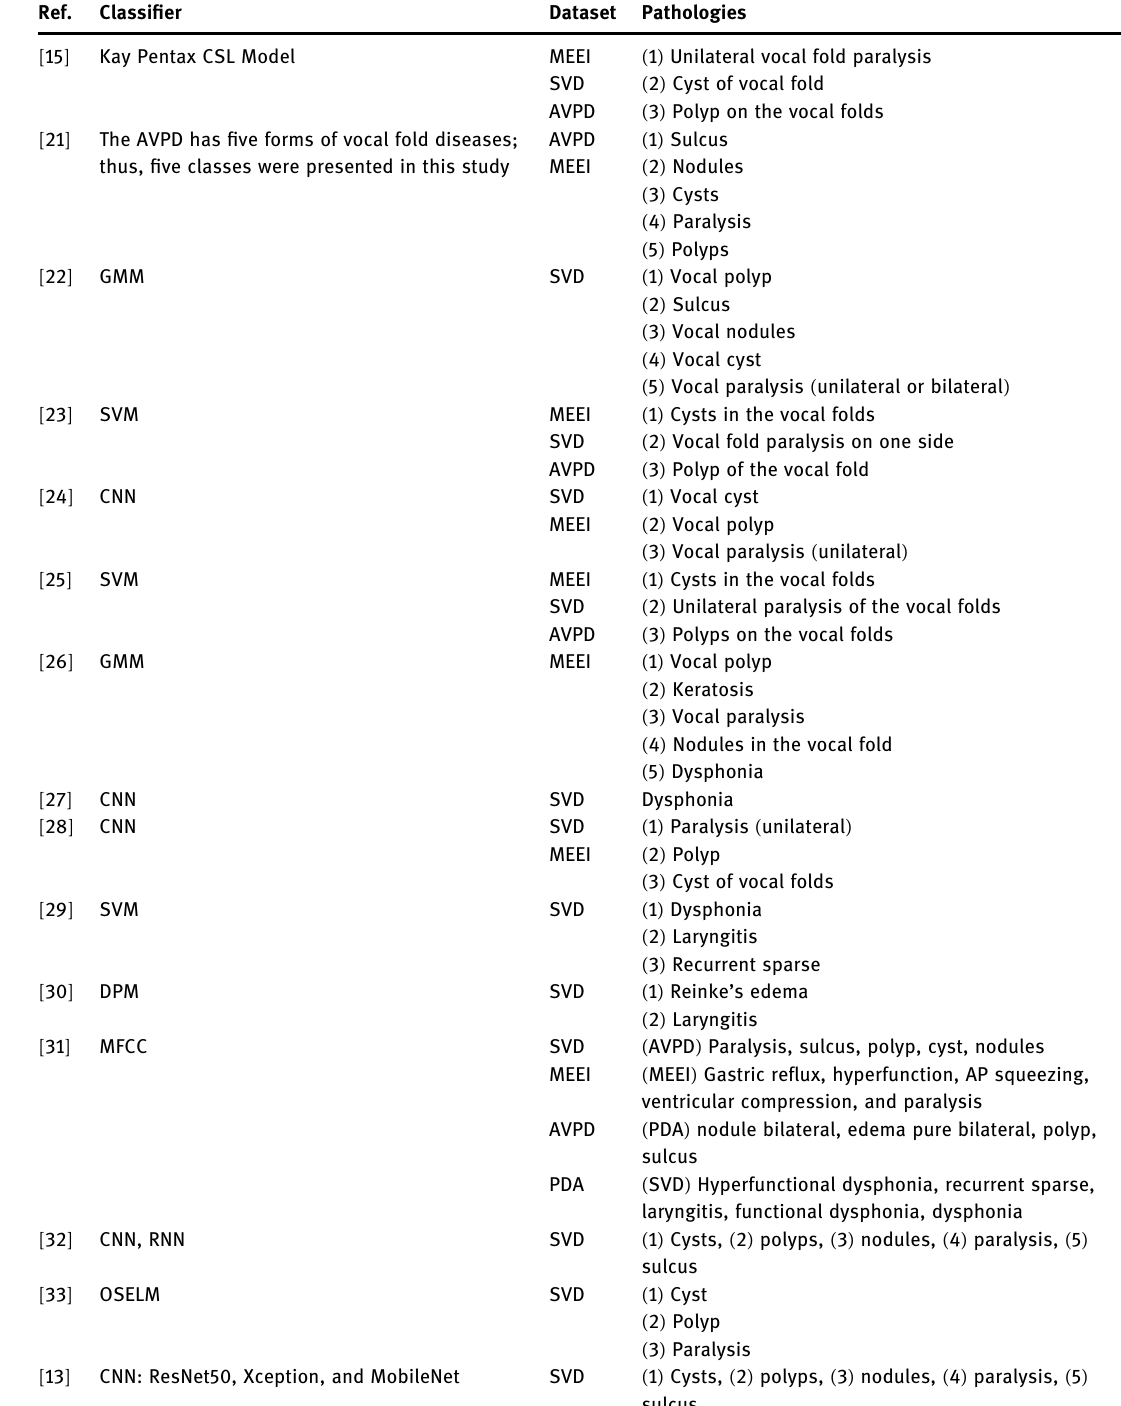
Table 1: Similar voice pathology detection and classi fi cation method studies